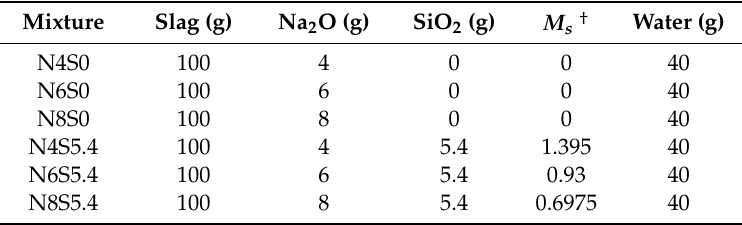
Table 2. Mix compositions of alkali-activated slag